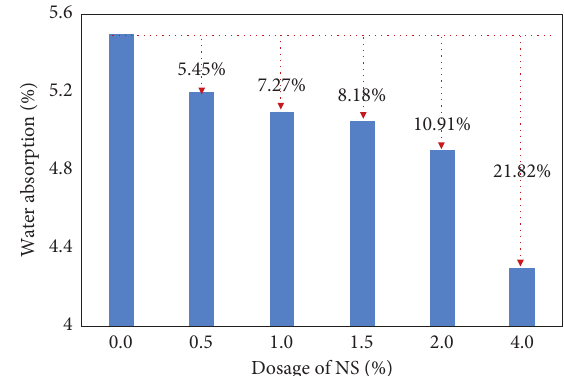
Figure 4: Effect of NS on water absorption of the C-FA system.